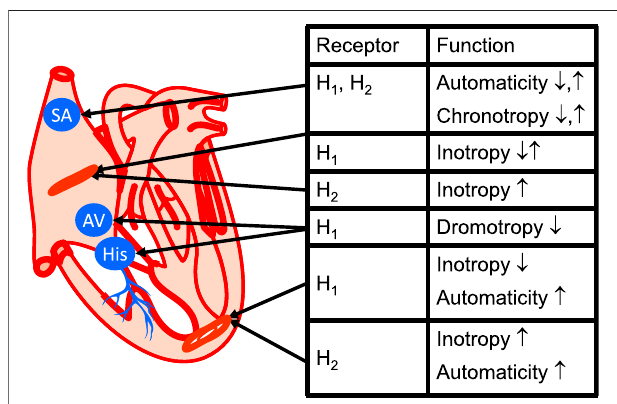
FIGURE4| Cardiac conducting system and regionalhistamine receptor expressionintheheart(modi fi edfromSteinetal.,1998).Here,onehastriedto relate the mechanical information in Figure 2 with anatomically correct location of the receptor. In the sinus node (SA), the H 2 -histamine receptor when it is expressed probably also increase chronotropy, that is increases the heart rate. If the H 1 -histamine receptor is functional, if can decrease but sometimes also increase the heart rate: this is meant by ↓ and ↑ (see Table 4 for species differences). For simplicity, in the ventricle a negative inotropic effect of H 1 -histamine receptor activation is only depicted. However, in some species a positive inotropic effect of H 1 -histamine receptor activation has been described (compare Table 4 ). If a functional H 2 -histamine receptor is expressed in the atrium or ventricle it always increases inotropy ( Table 4 ). Also indicated is the proarrhythmic effect of H 2 -histamine receptor stimulation in the ventricle by indicating increased automaticity. H 1 -histamine receptors, if present in the AV node (AV), always seem to have negative dromotropic effects,thatis,theyslowtheconductionthroughtheAVnode( Table7 ).Here, also His-bundles (HIS) are shown where adecrease in theconduction time via H